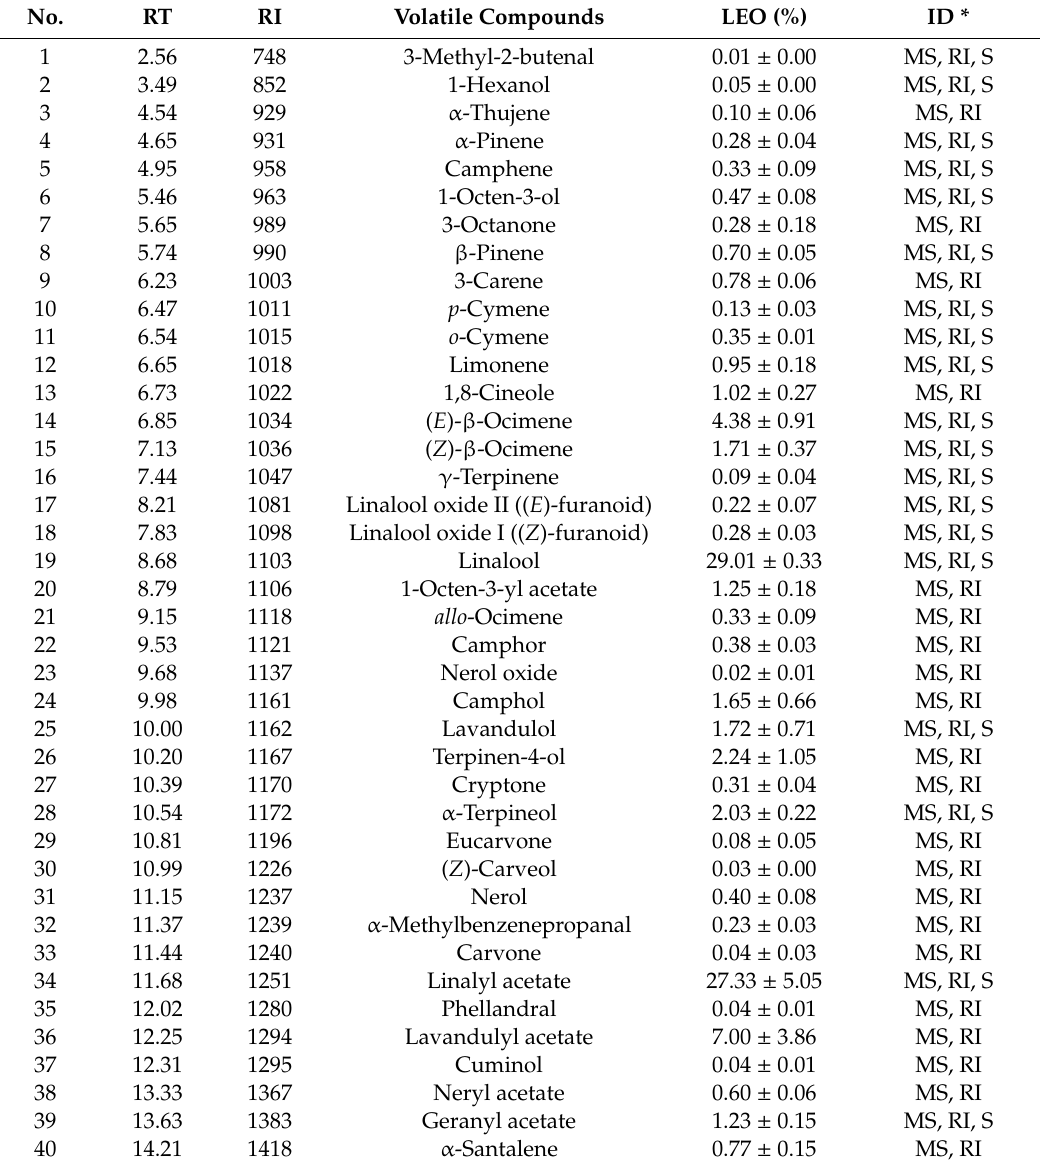
Table 3. Volatile compositions of lavender essential